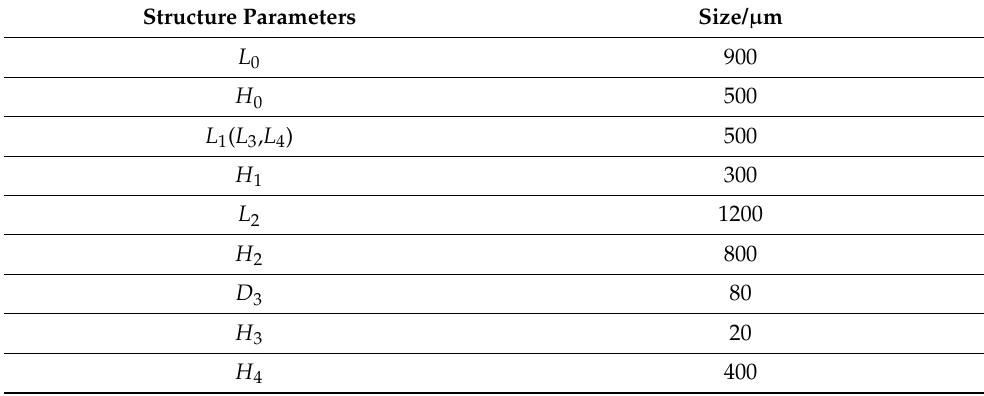
Table 3. Optimized cross structure parameters.